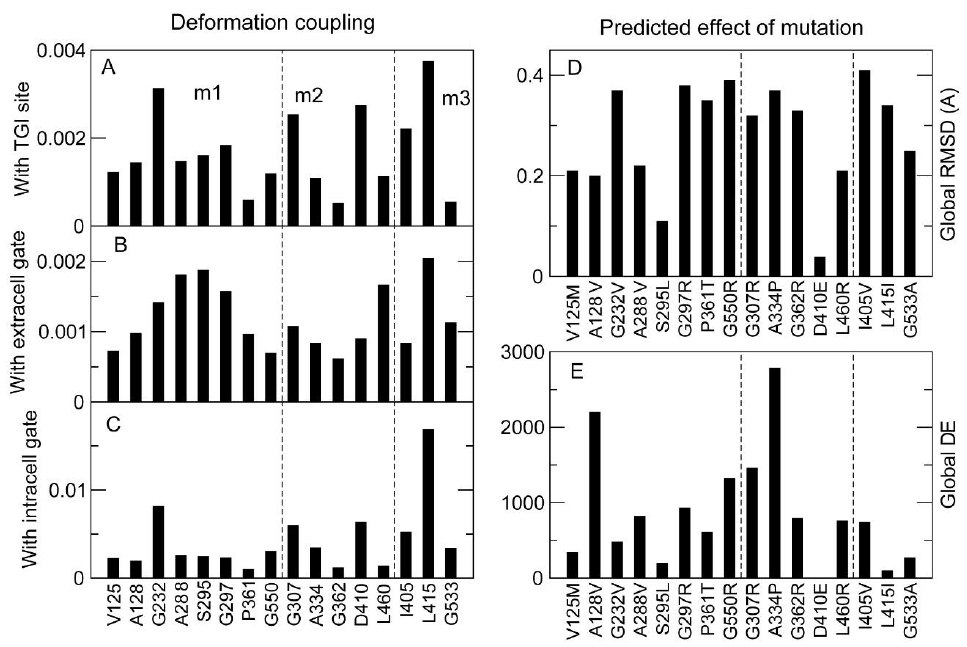
Figure 10. Deformation coupling between the 16 mutated sites (horizontal axis) and three func- tional sites: the tiagabine binding site (TGI) ( A ), the extracellular gate ( B ) and the